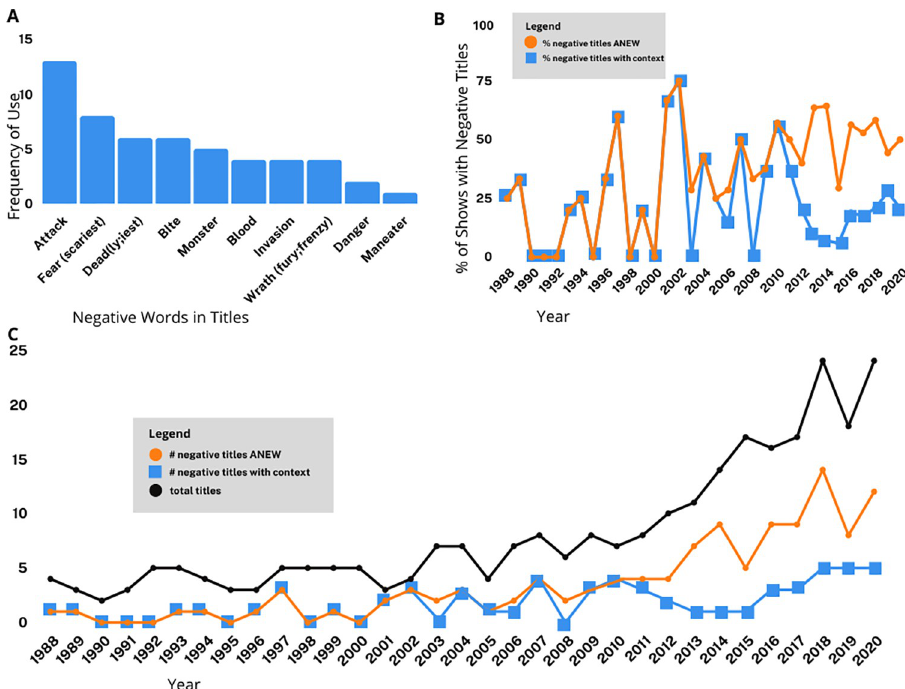
Fig 1. Trends in Shark Week episode titles. (A) Frequency of negative words used in episode titles; (B) Percent of episodes with negative titles per year. Orange circles indicate episode titles coded as negative based solely on the Affective Norms for English Words list (ANEW), blue squares indicate episode titles coded as negative by authors based on context (phrases rather than individual words); (C) Number of episodes with negative titles per year. Black circles indicate total number of episodes aired each year, orange circles indicate episode titles coded as negative based solely on the ANEW, blue squares indicate episode titles coded as negative by authors based on context.